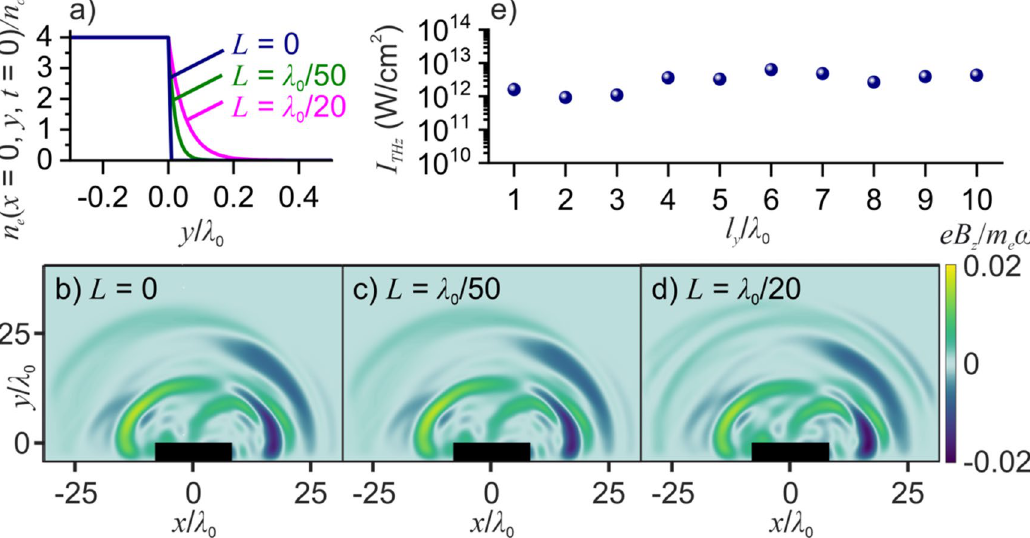
Figure 4. ( a ) Electron density profiles used in simulations. ( b – d ) The spatial distribution of the THz-filtered field B z ( x , y ) at t = 40 T 0 for ( g , h ) and 65 T 0 ( i ) for a plasma slab with L = 0 ( b ), λ 0 /50 ( c ), and λ 0 /20 ( d ) driven by a p -polarized laser pulse with τ 0 = 80 fs, λ 0 = 3.9 μm, and a 0 = 1. ( e ) THz output intensity as a function of the plasma depth l y for a p -polarized laser driver with τ 0 = 80 fs, λ 0 = 3.9 μm, and a 0 =